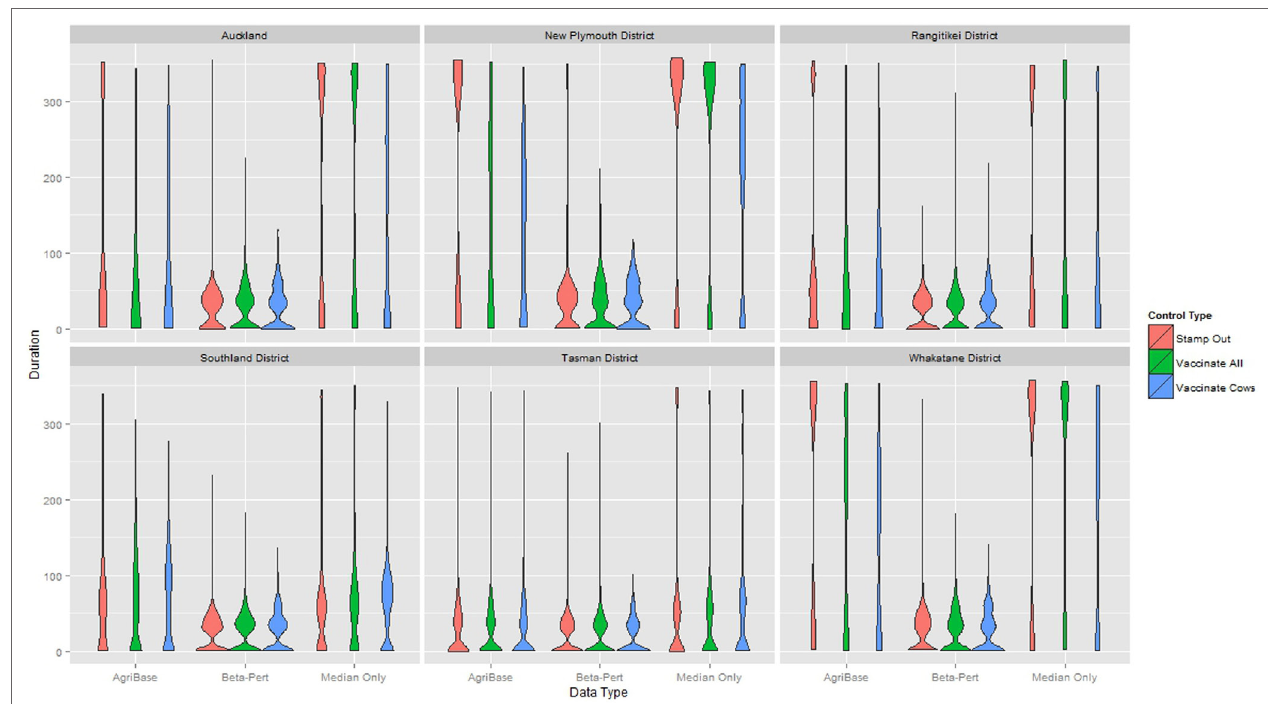
FigUre 2 | Distribution of duration of outbreak for models using each of three herd size data sets across six New Zealand territorial local authorities for three control strategies. FigUre 3 | Distribution of the log10 of final count of infected premises (IPs) for models using each of three herd size data sets across six New Zealand territorial local authorities for three control strategies.